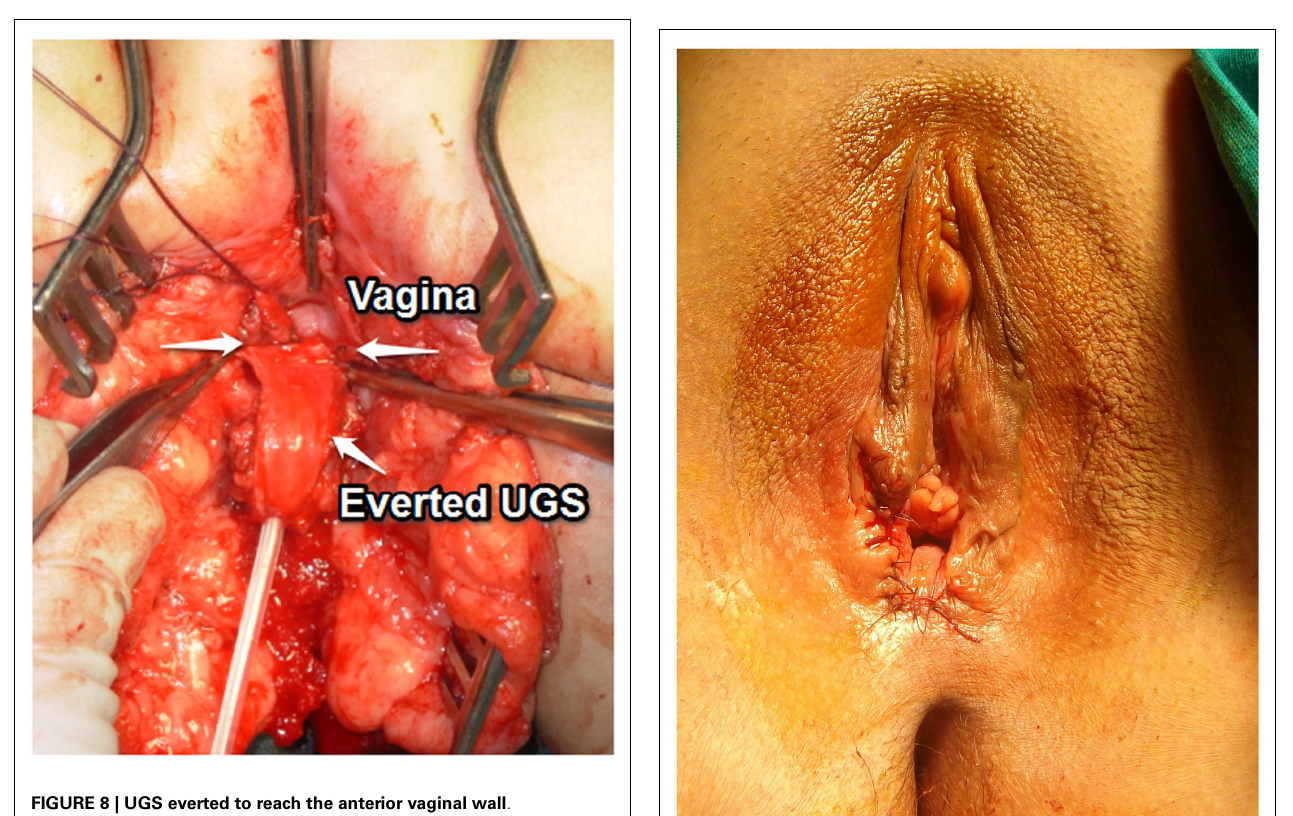
FIGURE 8 | UGS everted to reach the anterior vaginal wall .